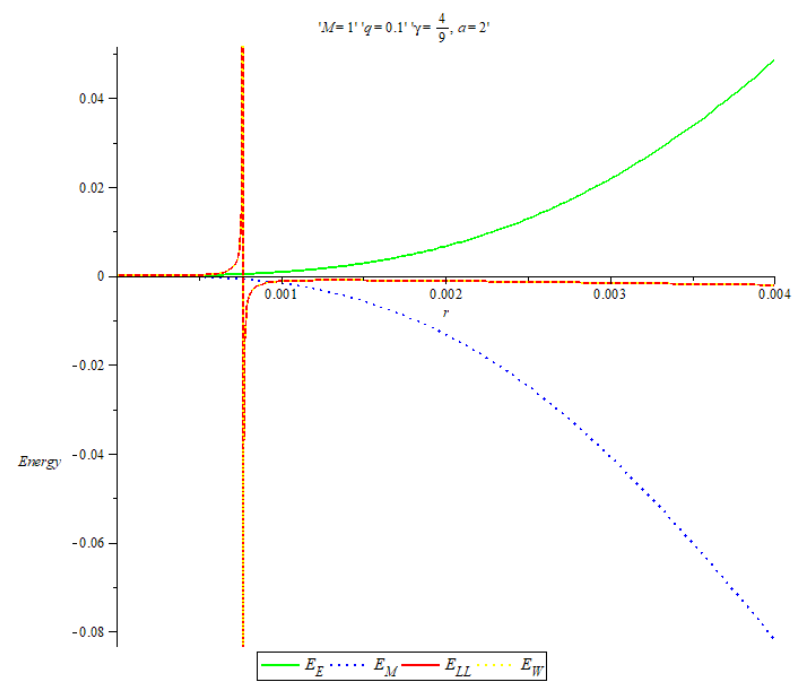
Figure 10. Comparison of energy in the Einstein, Landau-Lifshitz, Weinberg, and Møller prescriptions versus the radial distance r near the